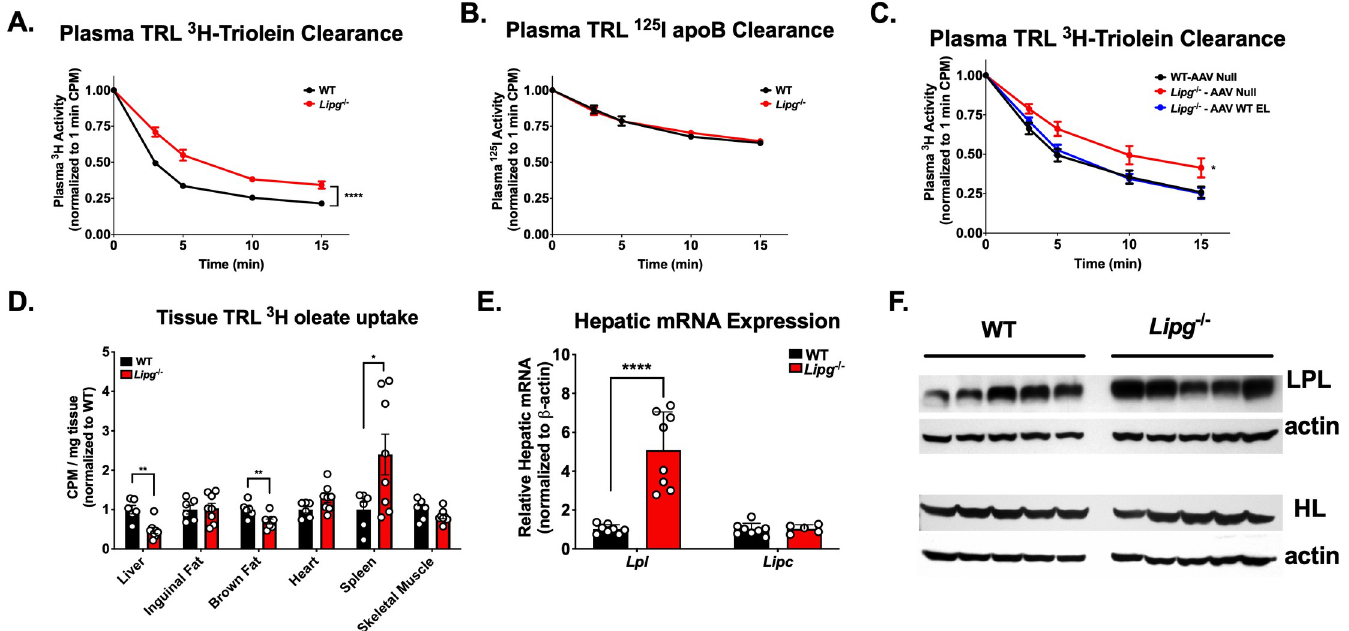
Fig 5. Lipg deficiency delays TRL lipolysis in mice. A. 3 H oleate plasma clearance curves from EL WT vs. Lipg -/- mice administered 3 H-triolein labeled human TRLs. Mice were administered radiolabeled TRLs and plasma 3 H levels were measured over 15 minutes and normalized to the 1 minute timepoint. B. Clearance of 125 I tyramine cellobiose labeled human TRLs in EL WT vs. Lipg -/- mice fed a high fat diet for 12 weeks. Plasma clearance of 125 I-TRL apolipoprotein B (apoB) after intravenous TRL administration was measured over 15 minutes. C. 3 H-triolein-labeled TRL clearance in WT mice treated with AAV Null vector, Lipg -/- mice treated with AAV Null, or Lipg -/- mice treated with AAV expressing murine Lipg and all fed a high-fat diet for 12 weeks and then treated with radiolabeled TRLs as described in (A). D. Uptake of 3 H-oleate into the indicated tissues after 15 min of administration of 3 H-triolein labeled TRLs in the mice from (A). 3 H activity in a fixed amount of tissue was normalized to the 1 minute plasma 3 H activity for each mouse. Normalized tissue 3 H activity is expressed for each tissue relative to the mean of the WT group. E . Hepatic mRNA expression of Lpl and Lipc in mice from (A). Quantitative real-time PCR cycle number for each gene was normalized to that of β -actin. F . Immunoblots of LPL and HL from liver lysates of mice in (A). Immunoblots of the proteins from the lysates for β -actin are shown as a loading control. A, C: � P < 0.05, ���� P < 0.0001, repeated factor 2-way ANOVA. D & E: � P < 0.05, �� P < 0.01, ���� P < 0.0001, student’s unpaired T-test. Data is expressed as mean ± S.E.M.